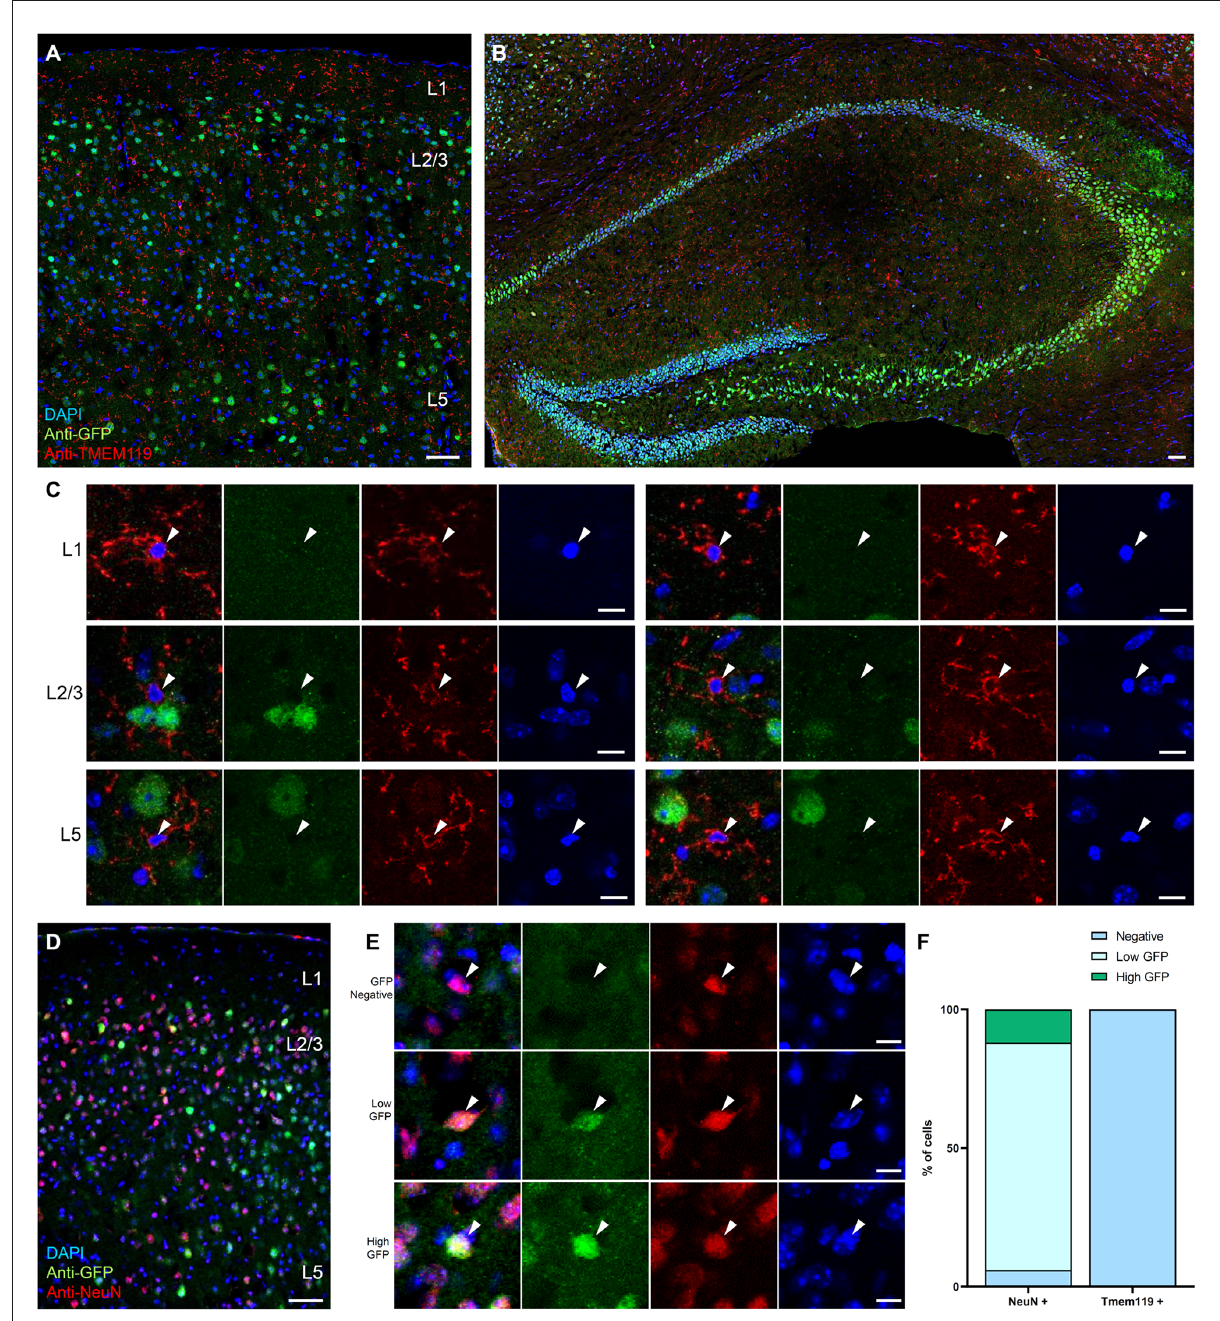
FIGURE4 Microglia do not express the reporter for BDNF translation BDNF-P2A-GFP. Low magnification images of the Bdnf-P2a-Gfp reporter mouse line immunostained against the microglial marker TMEM119 (red), in (A) the motor cortex and in (B) the hippocampus. (C) Representative high magnification images of TMEM119 expressing microglia (red) from L1, L2/3, and L5 showing the absence of GFP signal. (D) Low magnification image of the motor cortex from a Bdnf-P2a-Gfp mouse cortical section immunostained against the neuronal marker NeuN (red). (E) Representative high magnification images of NeuN expressing neurons (red) showing differential levels of Bdnf mRNA translation (GFP). (F) Quantification of the percentage of neurons and microglia expressing BDNF-P2A-GFP. Scale bar: (A,B,D) : 50 µ m, (C,E) : 10 µ m.